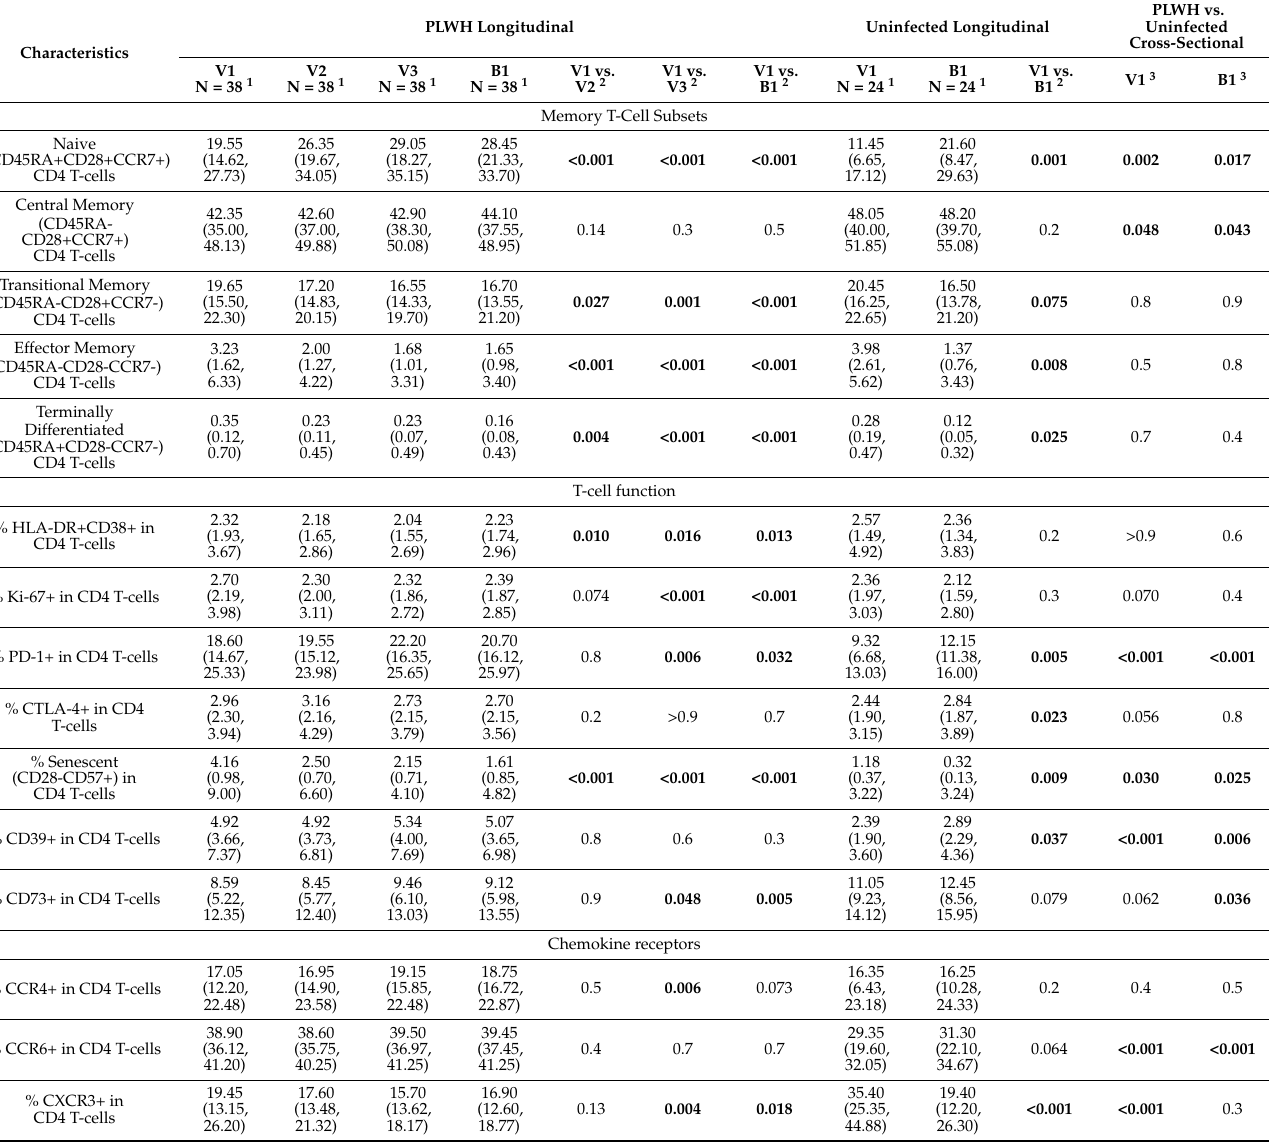
Table 2. Changes in frequencies of CD4 T-cell subsets following SARS-CoV-2 vaccination in PLWH and uninfected controls. Results are presented as median (IQR) of the percentage (frequencies) within total alive CD4 T-cells. Study visits: V1—pre-vaccination baseline, V2—1 month post 1st dose, V3—3 months post 2nd dose, B1—1 month post 3rd dose. Significant differences ( p < 0.05) are highlighted in